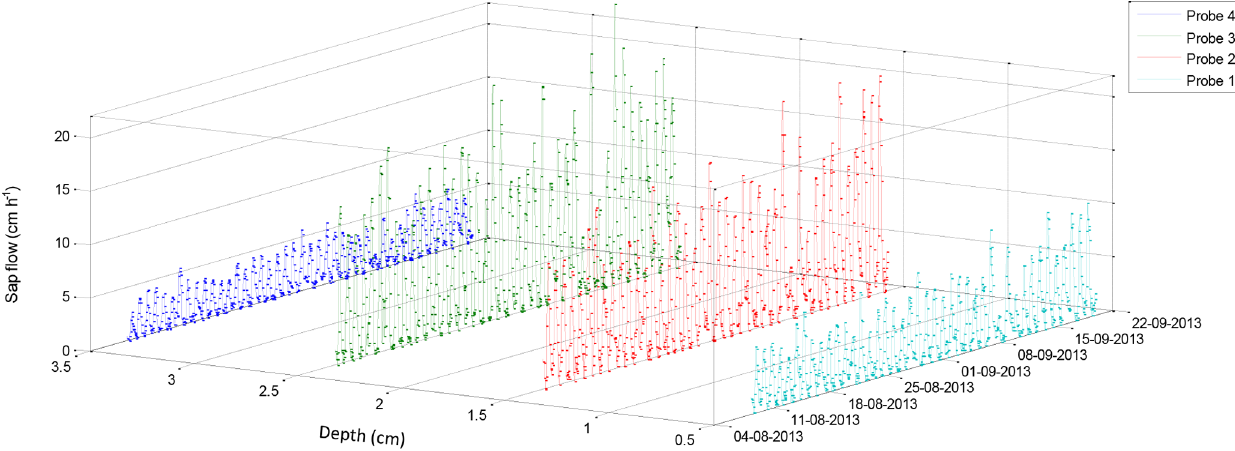
Figure 5. Hourly heat pulse velocity of an A. mearnsii (Ø: 131mm) at New Forest. Table 2. Sap flow (daily and accumulated) for each species measured at New Forest. Forest type/ Species Diameter Daily average Daily average Standard Annual location (mm) summer sap winter sap deviation accumulated sap flow (Ld − 1 ) flow (Ld − 1 ) flow (La − 1 ) 9